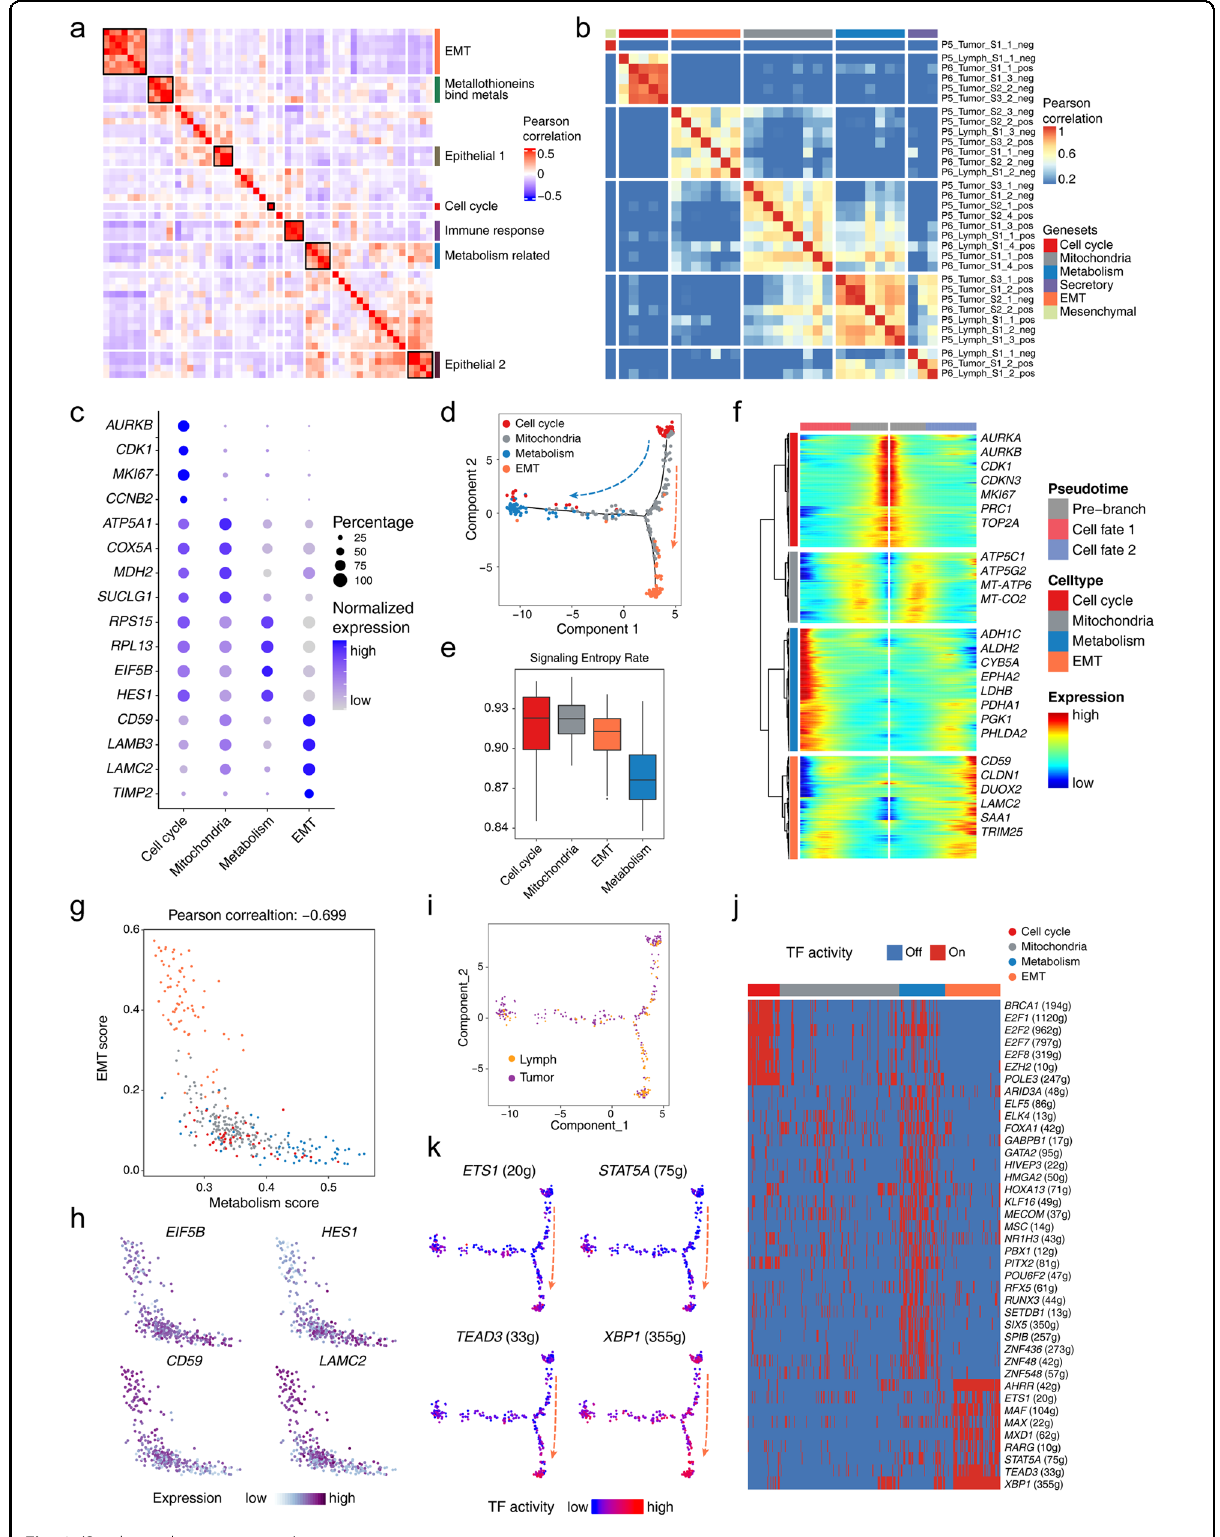
Fig. 3 (See legend on next